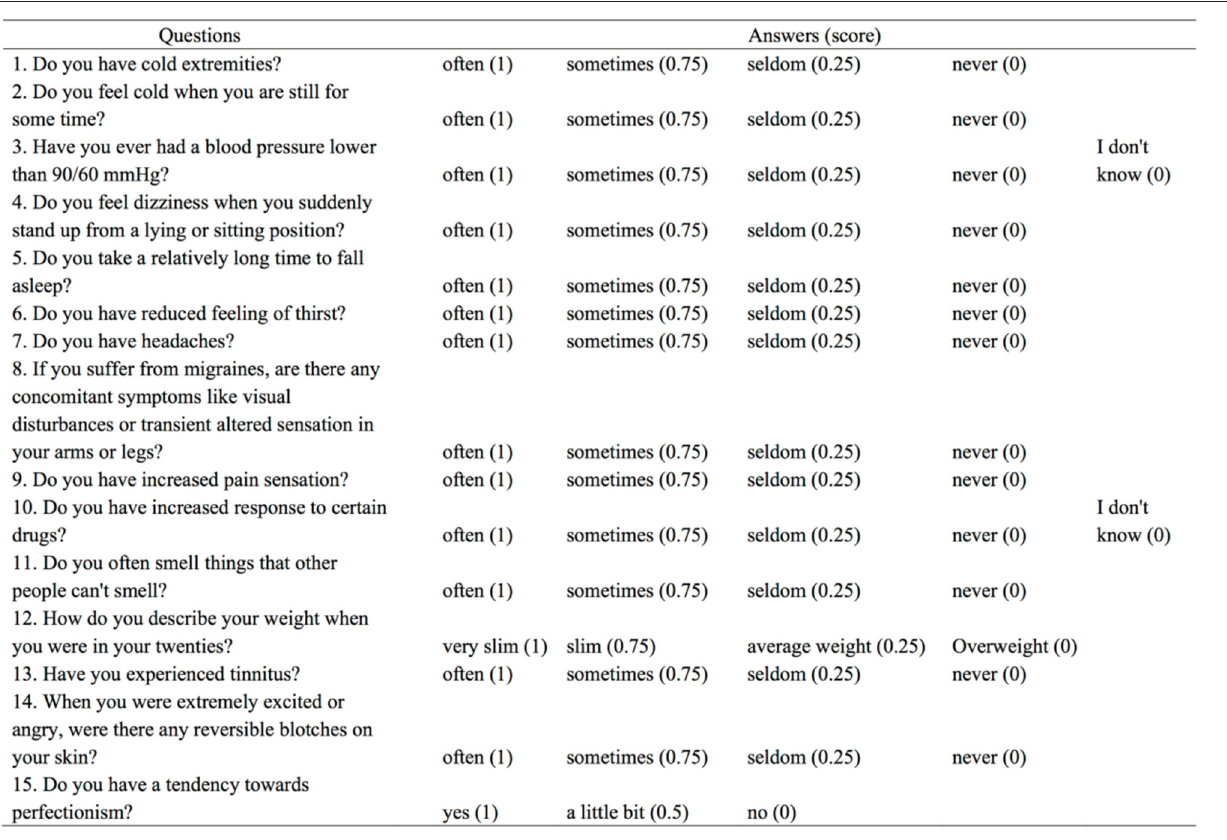
FIGURE 1 | Questions and scoring of Flammer Syndrome Questionnaire.